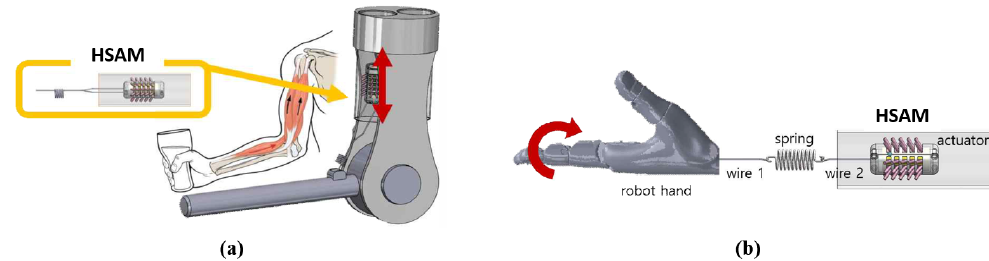
Figure 5. The two applications to demonstrate the feasibility of the proposed HSAM: ( a ) elbow manipulator; ( b ) robot hand grasper.